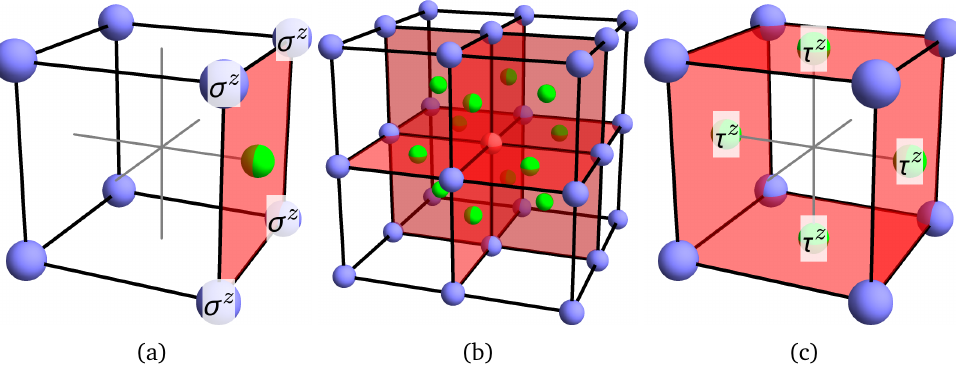
Figure 3: Gauging planar symmetry on a cubic lattice. (a) The minimal symmetric coupling term: a product of four σ z around a plaquette (of the cubic lattice of blue spheres). A gauge field τ (green sphere) is therefore placed at the center of the plaquette, and all other plaquettes. The gray lines form the dual lattice. (b) The red vertex is involved in the twelve minimal coupling terms highlighted by red squares. The gauge symmetry term is a product of a σ x at the red sphere and twelve τ x on the green spheres. (c) The product of four minimal coupling terms around the four blue plaquettes is the identity. The corresponding flux term is a product of four τ z on the green